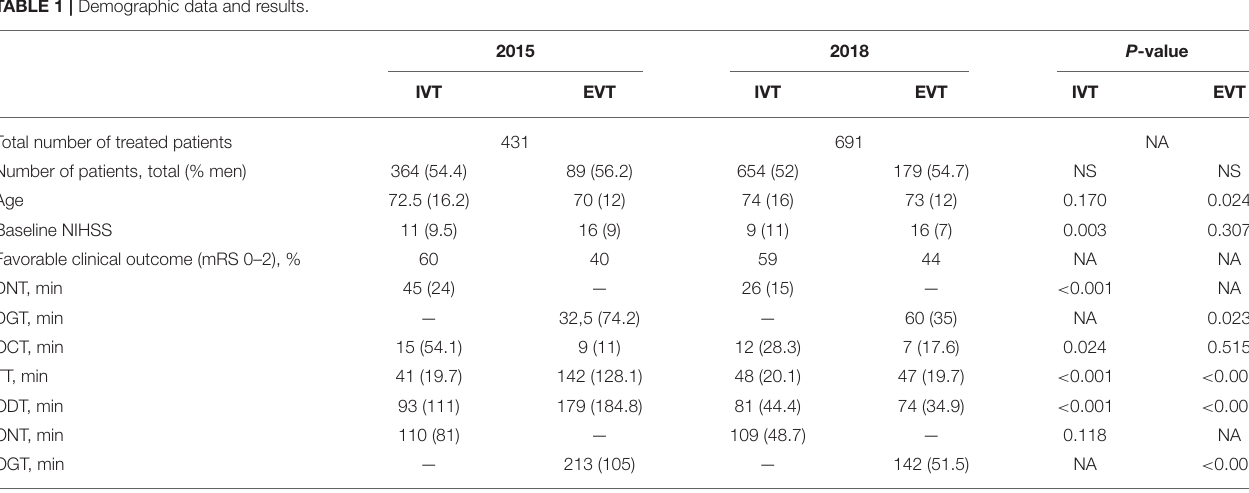
TABLE 1 | Demographic data and